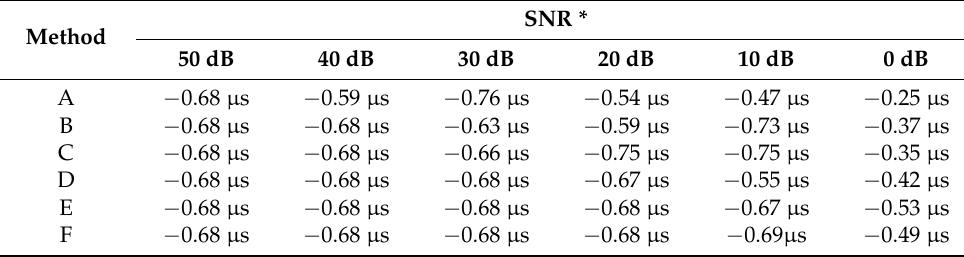
Table 7. The time difference results from the six algorithms with white noise.